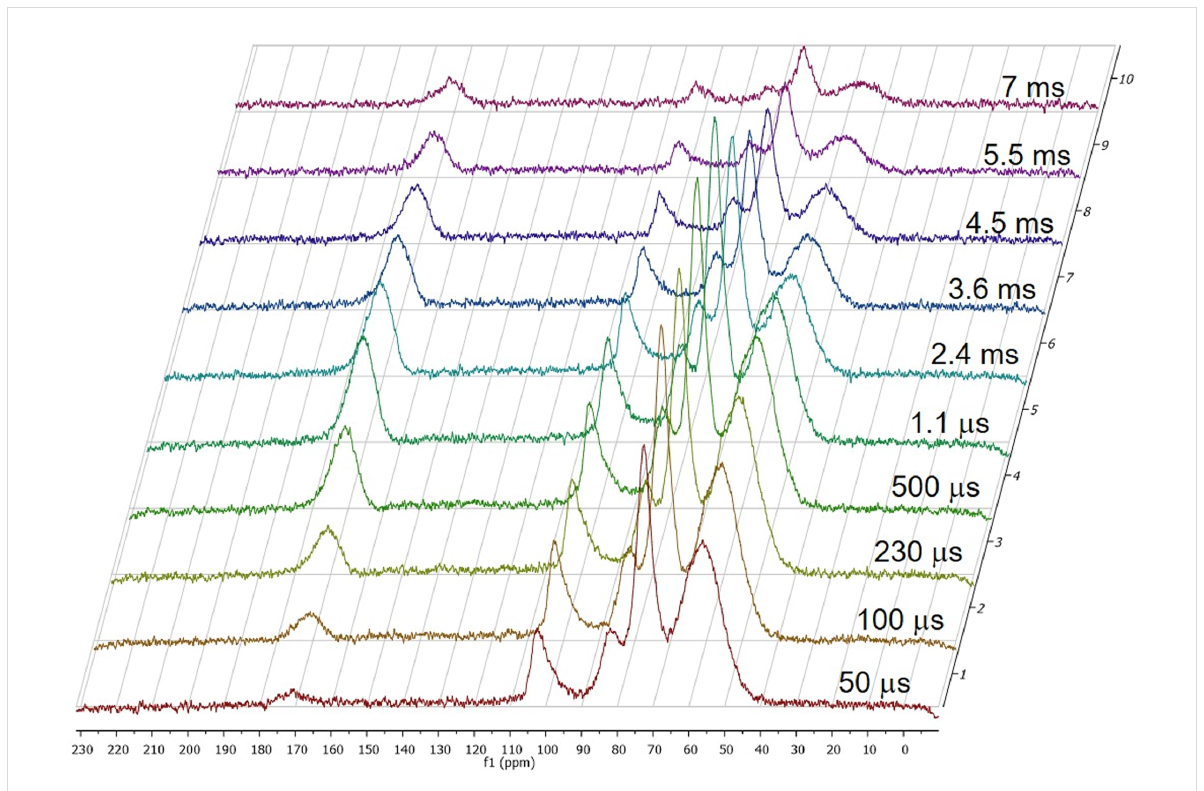
Figure 6: 13 C CP-MAS NMR spectra of CDNS(1:4) acquired with CP variable contact time in the range 50 μ s–7 ms.